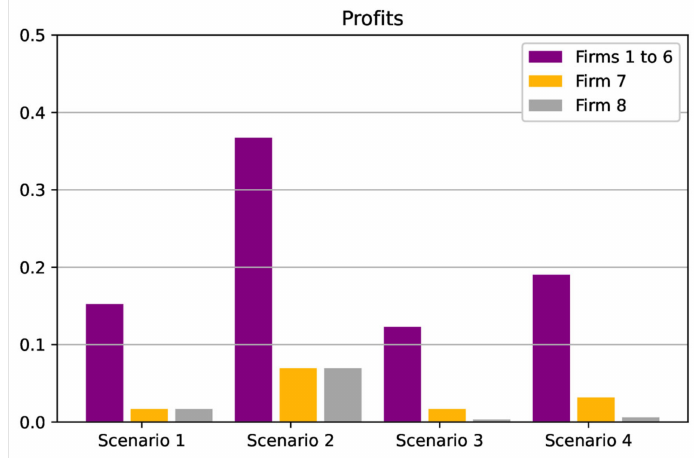
Figure 10. Profits in each scenario. The profits are obtained based on the normalized total output of all firms. Profits of firms 1 to 6 are